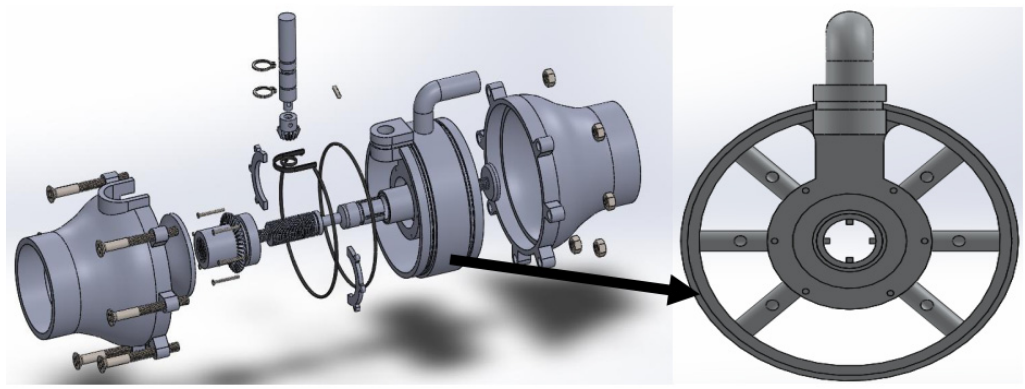
Figure 2 . Three-dimensional view of the new mixer.